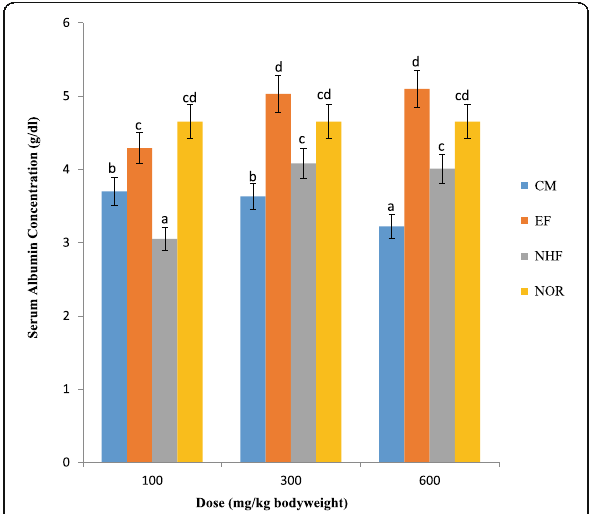
Fig. 6 Effect of crude extract and fractions of Gymnema sylvestre on serum albumin concentrations of rats. Mean with different superscripts differ significantly (p < 0.05). Key: NOR: normal control, CM: crude methanol extract, EF: ethyl acetate fraction, NHF: n-hexane fraction